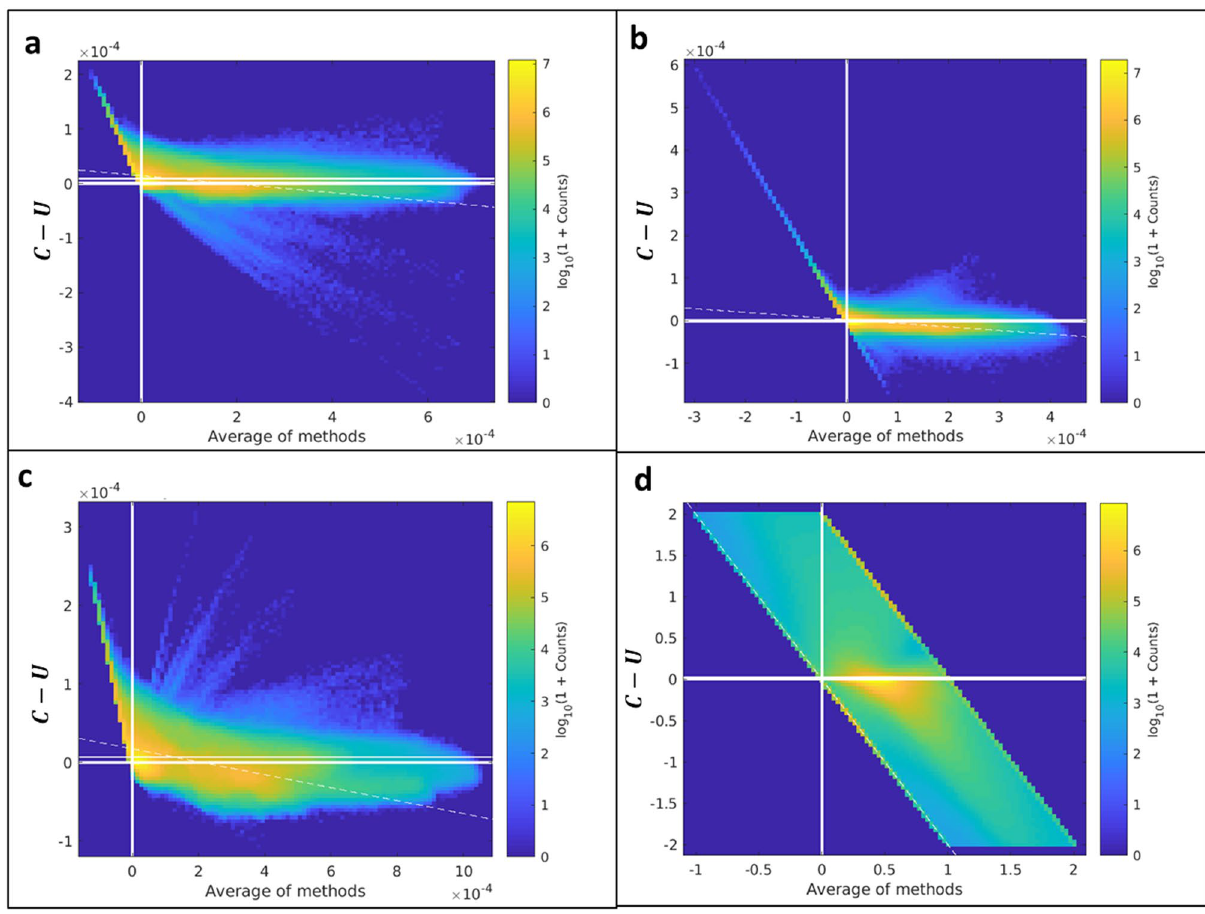
Figure 8. Bland–Altman plots between the constrained and unconstrained analyses on Dataset A. ( a ) [HbO 2 ] MSOT , ( b ) [Hb] MSOT , ( c ) [Hb tot ] MSOT , ( d ) SO 2 MSOT . There is generally good agreement throughout all channels, though there appears to be a consistently lower estimate of all parameters using the constrained approach. The appearance of diagonal structure in ( a – c ) is due to the non-negative constraint, while the band of finite width in ( d ) is the result of the constrained method’s SO 2 estimates being confined to [0,1]. Figure created using a combination of MATLAB and Microsoft number of small-scale anomalous responses (Fig. 10, white arrows) due to the non-physical values of various parameters in those pixels. In contrast, the relative effect of the constrained SO 2 MSOT is much more consistent, showing vessel-like structures in the response within the tumor bulk, with a dramatically reduced occurrence of anomalous responses. Increases in correlation against the known pO 2 waveform were seen for both the α and αβ constrained meth- ods when compared to the unconstrained approach (Figs. 11, 12). Though the distributions of correlation were similar (Fig. 11), the constrained methods improved the positive correlation with [HbO 2 ] MSOT and SO 2MSOT and the negative correlation with [Hb] MSOT , while having a relatively mild effect on [Hb Tot ] MSOT (Fig. 12). Despite the visual similarities in correlation values between α and αβ filtered timeseries (Fig. 11), the αβ filter has the advantage of quickly following dynamic changes, while the α filter naturally suffers from a lag time after such changes. Nevertheless, the α filter suppresses noise effectively, leading to the improved correlations shown in Fig. 12. The improvements in correlation were particularly significant in the HbO 2 and SO 2 channels, possibly reflecting the suitability of these channels for measuring response to gas challenge. The constrained methods were also able to achieve better model fits, as seen in Fig. 13. The unconstrained approach provided results which were generally consistent with the constrained approaches, but resulted in many noncausal switching time values in the tumor region. The process of reconstruction benefits from parallelization, enabling faster processing. As shown in Fig. 14, even a few additional logical cores, as is available on most modern processors, provided dramatically improved performance. The model-based approaches generally benefited more from this parallelization; due to the larger proportion of the processing time per-frame taken up by the solution process itself, increased parallelization provides greater benefit to the model-based reconstructions. Diminishing returns with increasing numbers of processors are attributable to network and hard-disk limitations. We note that the scaling performance is com- parable for each method, indicating that the relative overhead of parallelization for each method is comparable.